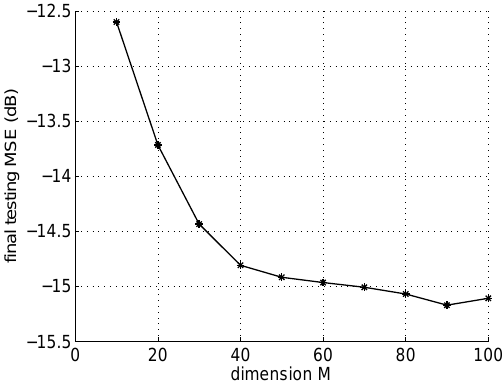
Figure 2. The curve of final testing mean square error for the randomized feature networks-based kernel least mean square algorithm (KLMS-RFN) as the dimension M increases from 10 to 100.